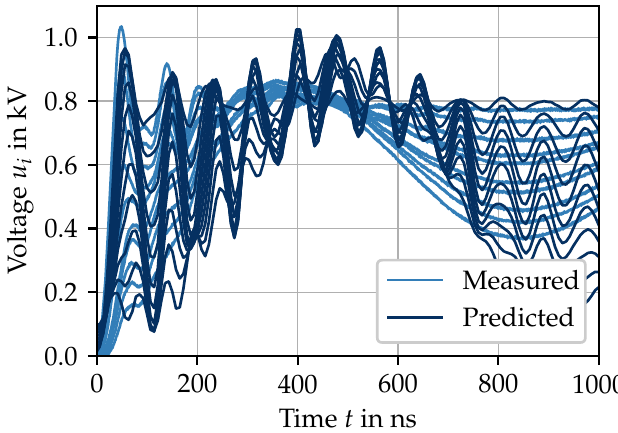
Figure 13. Turn-to-ground voltages for the first ten turns of stator specimen S3, measured and predicted, with an input voltage gradient d u /d t = 30V/ns. Figure 13. Measured and predicted turn-to-ground voltages for the first ten turns of stator specimen S3 with an input voltage gradient d u /d t = 30 V/ns